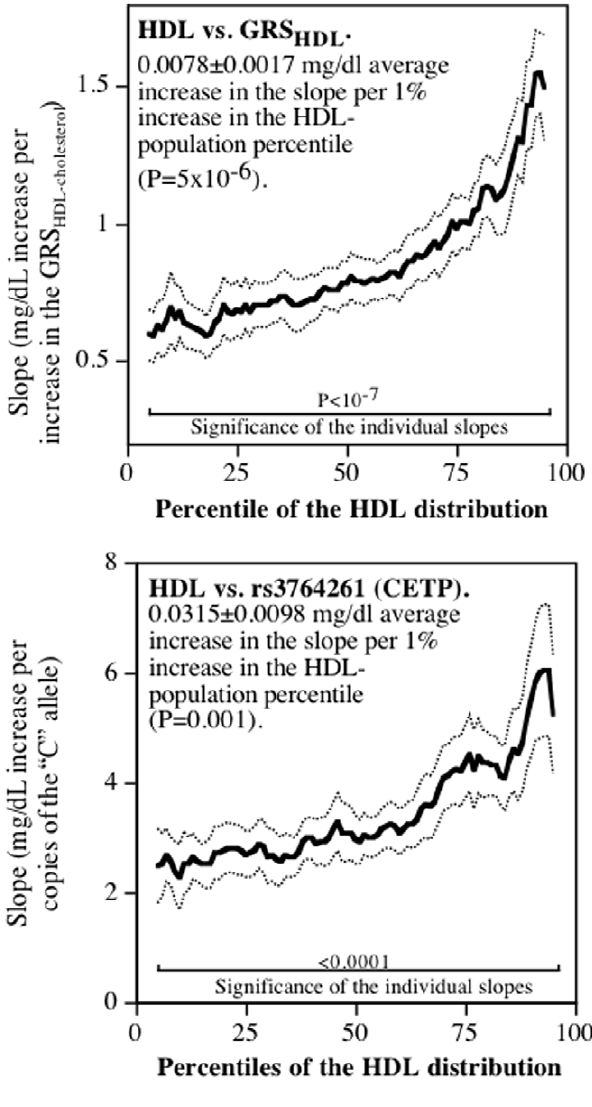
Figure 2. Slopes for HDL-cholesterol versus GRS HDL-cholesterol and the number of C alleles for rs3764261 (CEPT, Y-axis) by percentiles of the HDL-cholesterol distribution (X-axis). Lighter lines designate 6 one standard error.